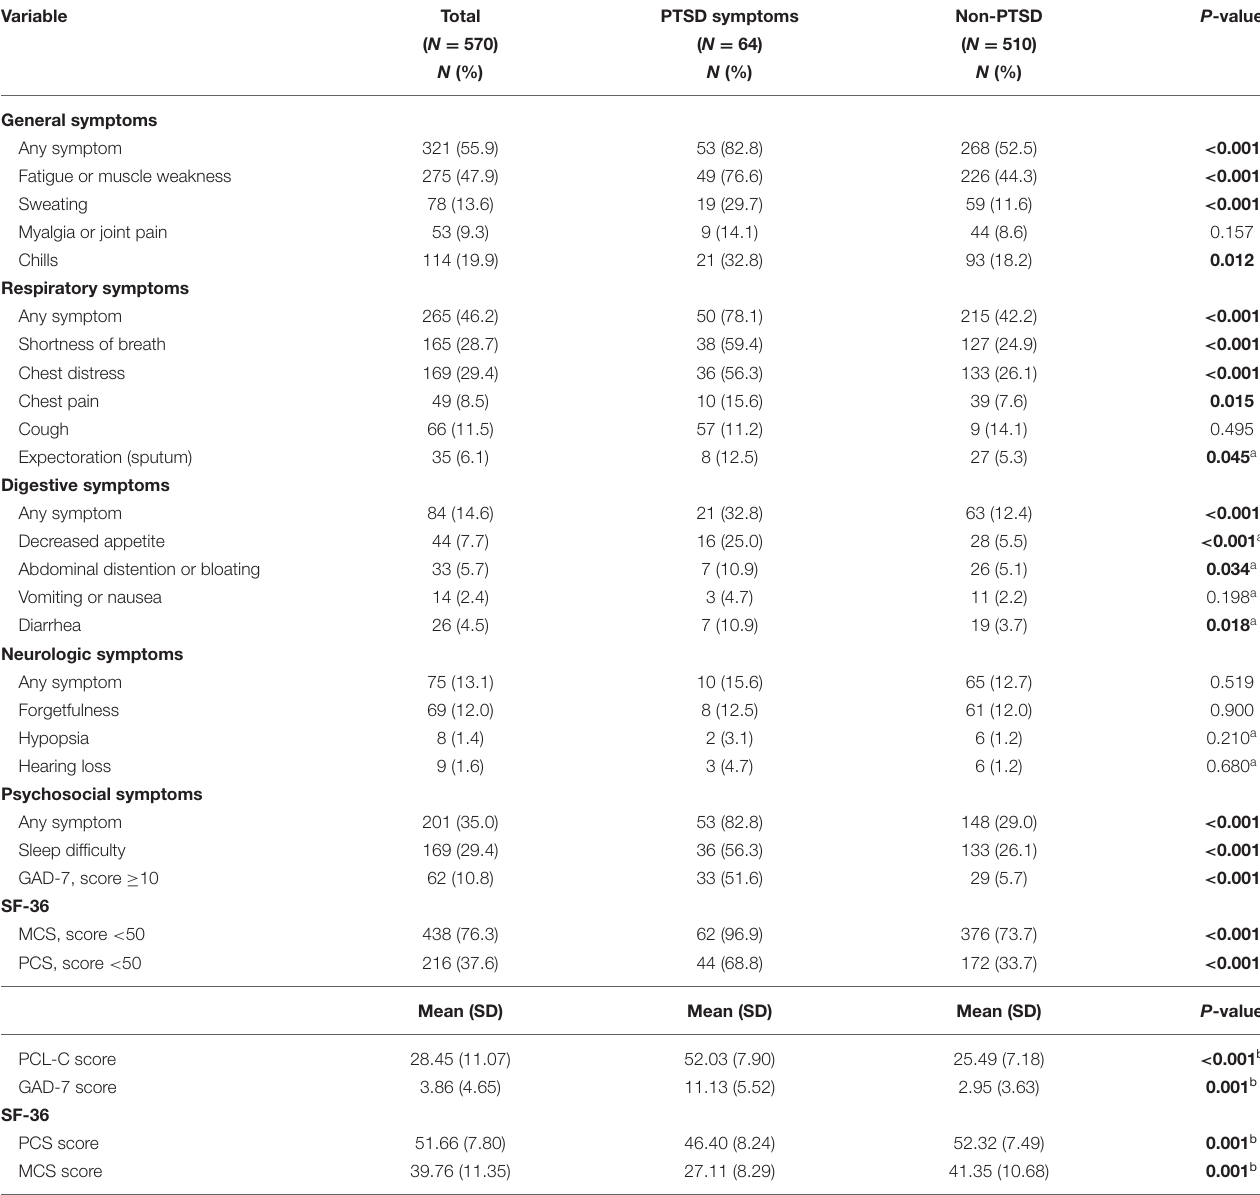
TABLE 2 | Clinical sequelae of COVID-19